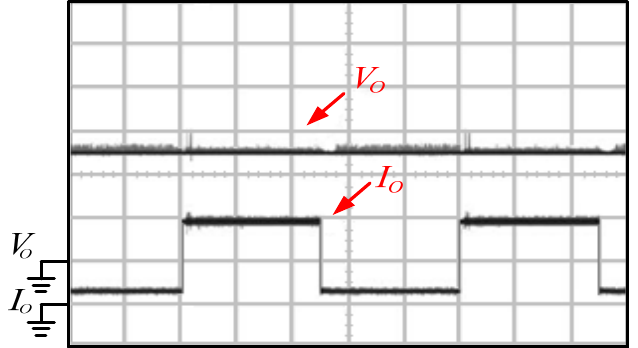
Figure 19. Measured output voltage, current and power waveforms of PV arrays at steady-state MPPT. ( P